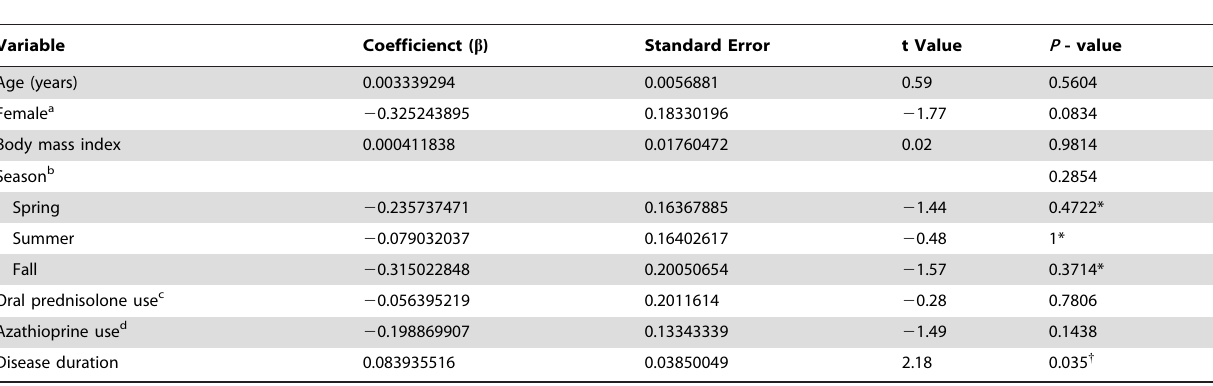
Table 2. Multivariable logistic regression analysis for the relationship between 25-hydroxyvitamin D 3 (25(OH)D 3 ) levels and age, sex, body mass index, season, oral prednisolone use, azathioprine use and disease duration in patients with neuromyelitis optica spectrum disorder.